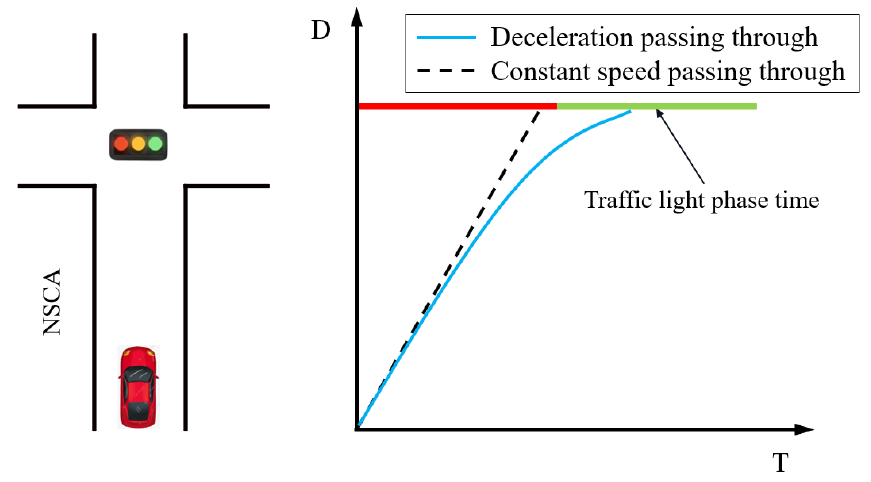
Figure 9. Deceleration passing through.